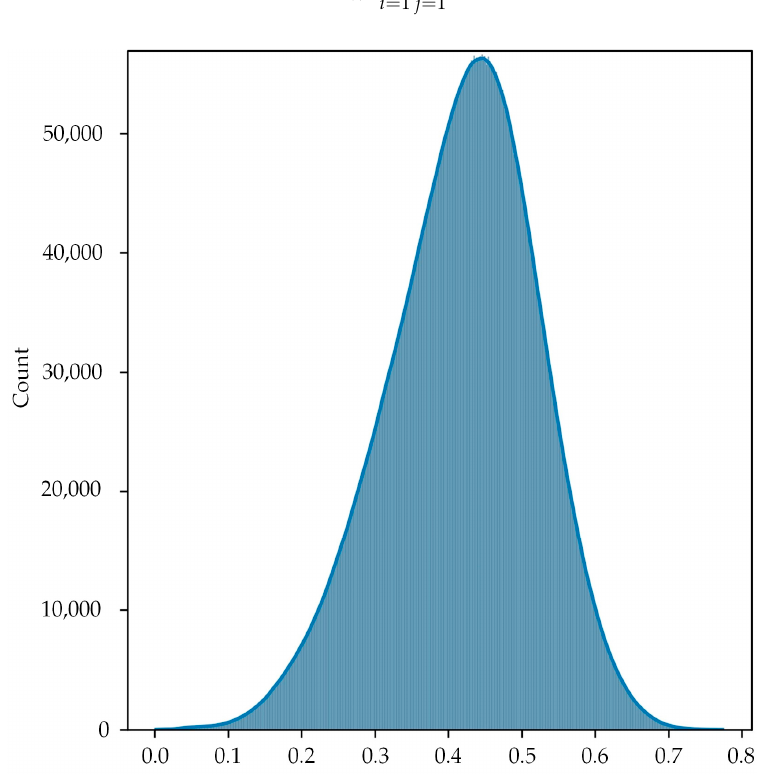
Figure 7. Histogram distribution of image cosine distances in the visual map.